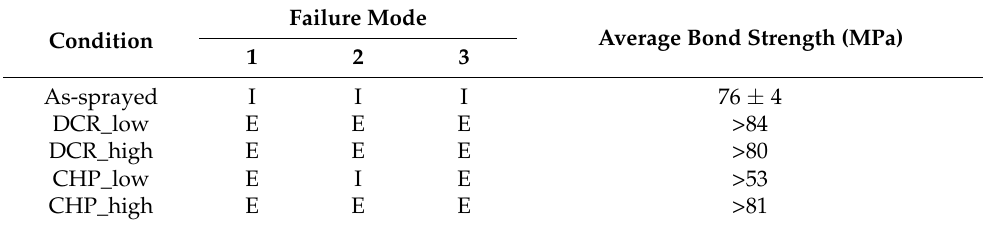
Table 4. Results of bond strength testing. I: Failure at the coating substrate interface. E: Failure at the